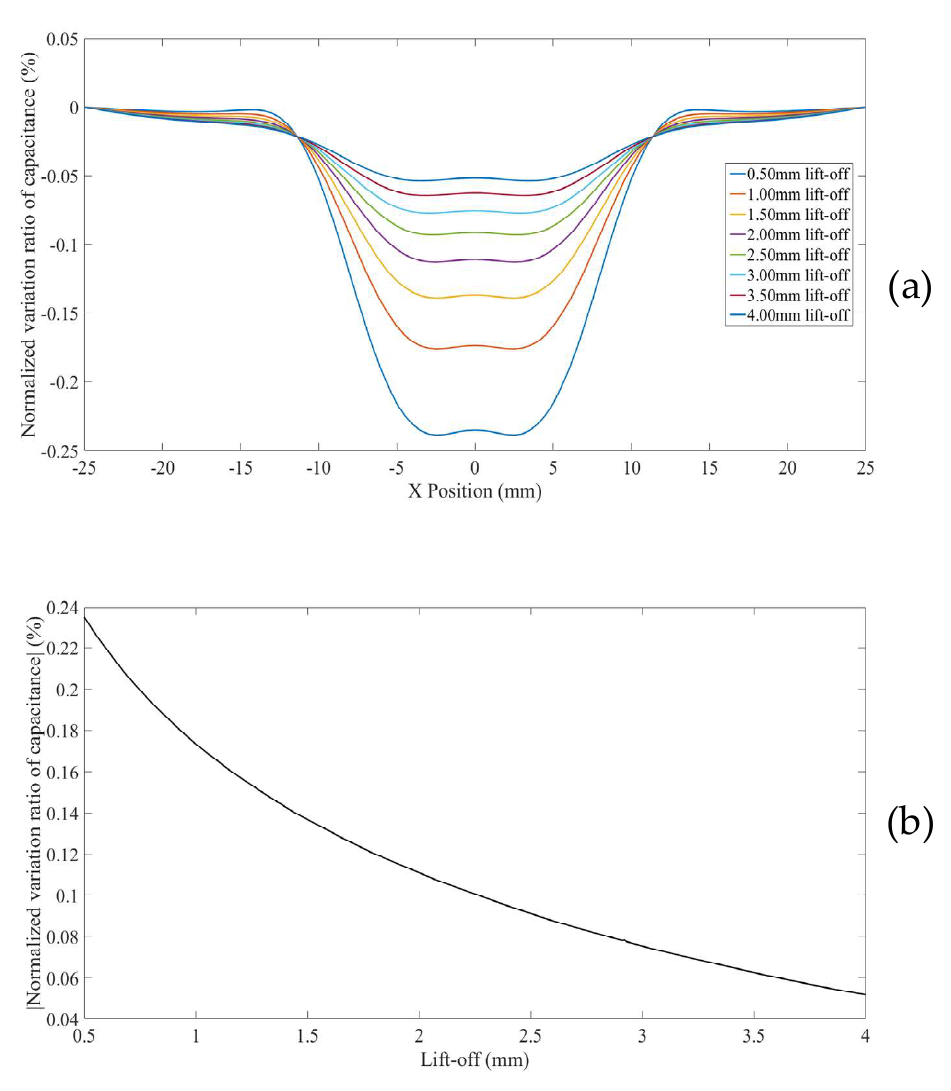
Figure 12. ( a ) NVR curves for Model 6 with lift-offs increased from 0.5 mm to 4 mm and ( b ) absolute values of the NVRs at the centre point against lift-offs.